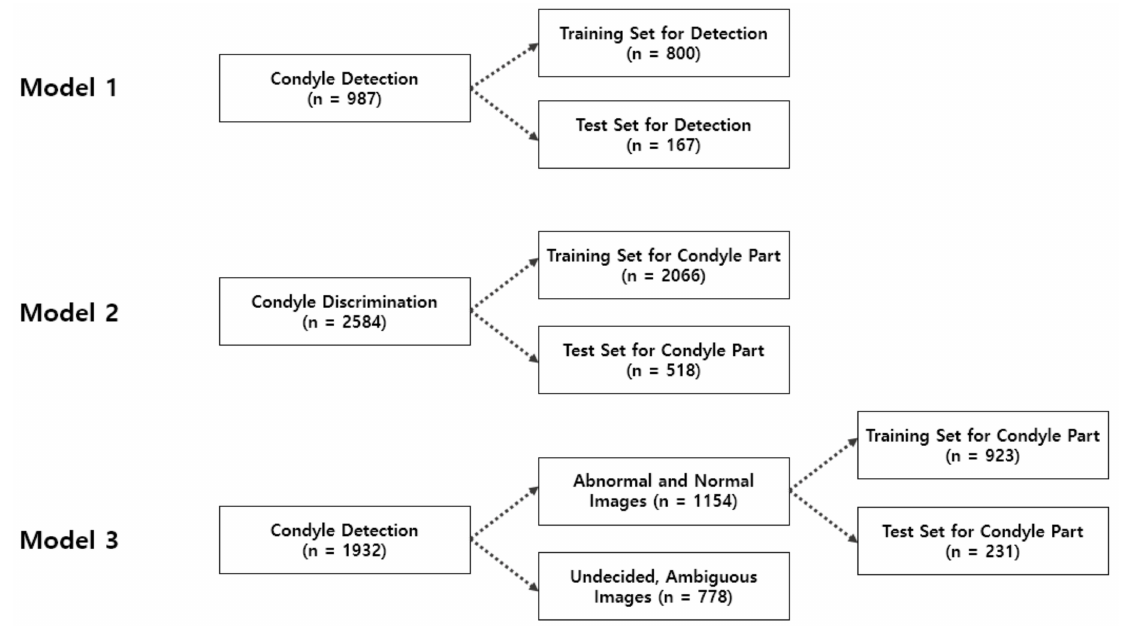
Figure 2. Datasets used to train Models 1, 2, and 3.